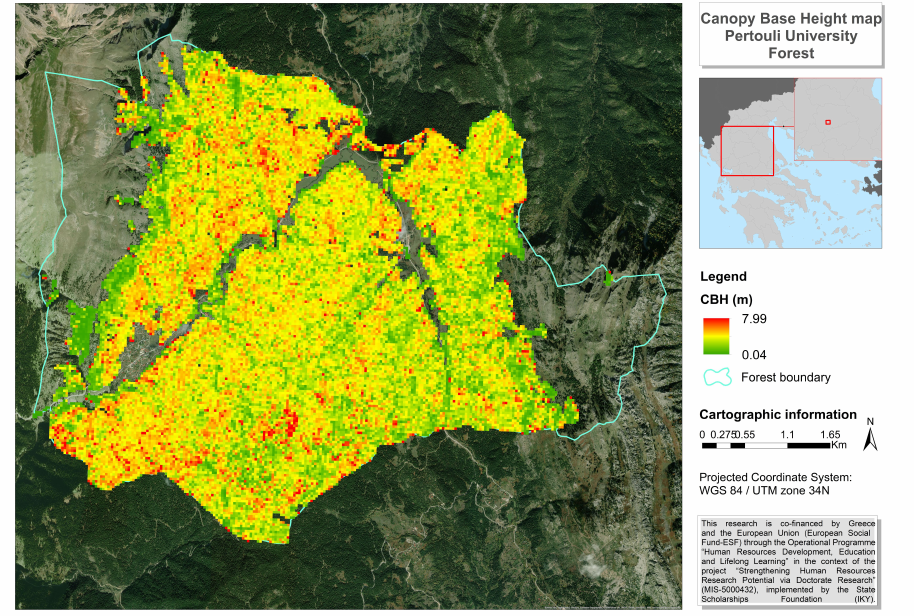
Figure 11. Canopy base height (CBH) map (32 m spatial resolution) produced for the Pertouli University Forest by applying the predictive regression model to the LiDAR point cloud of the entire study